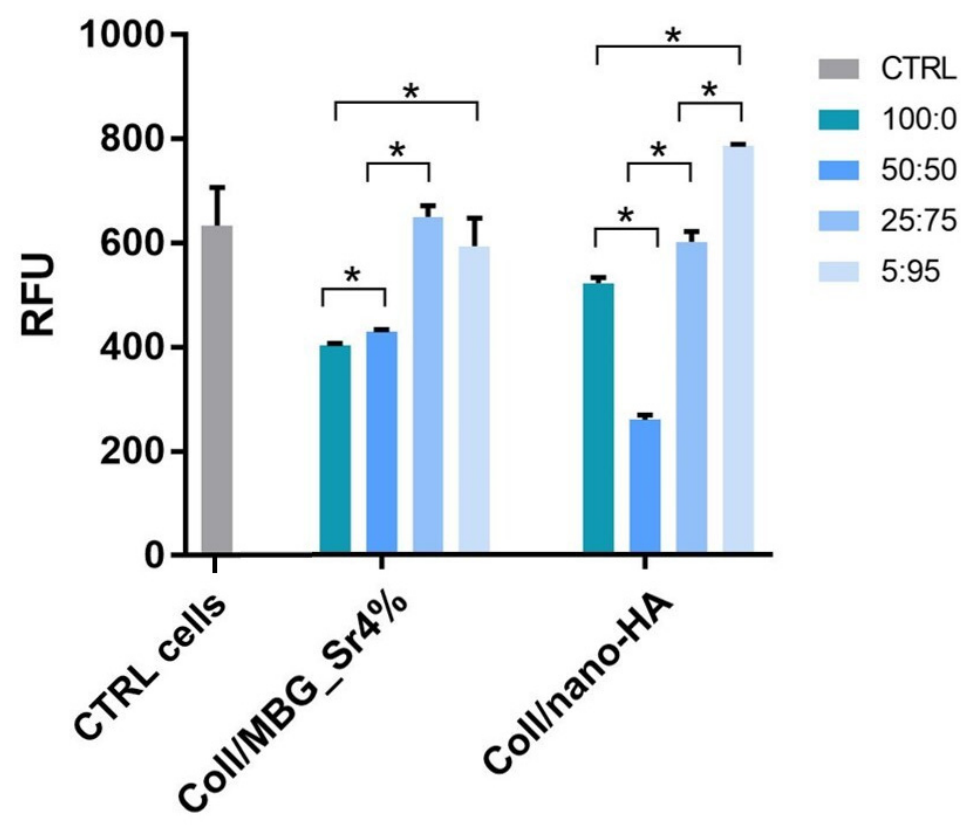
Figure 7. Cell viability by the Alamar Blue assay applied on the indirect co-culture maintained for 24 h in the conditioned medium (CM) diluted 100:0, 50:50, 25:75, and 5:95 with fresh culture me- dium. Only the p ≤ 0.05 was considered as statistically significant. Statistical analysis among CTRL cells and the other samples was performed as follows: CTRL cells and CM 100:0, 50:50; and 25:75 of Coll/MBG_Sr4% p = 0.0495; CTRL and CM 5:95 of Coll/MBG_Sr4% p = 0.517; CTRL and CM 100:0, 50:50, 25:75, and 5:95 of Coll/nano-HA p = 0.0495 (* p -value ≤